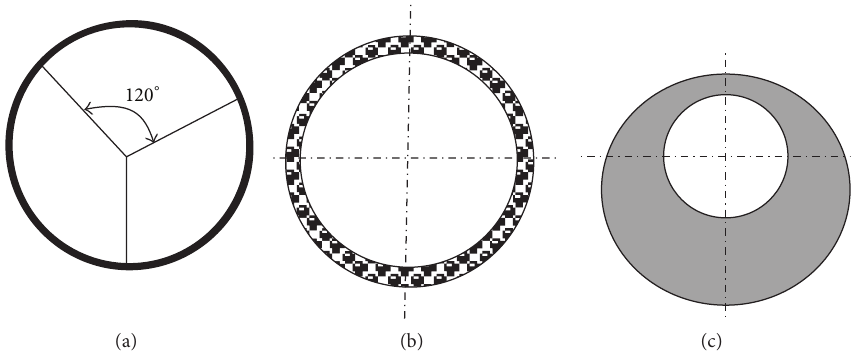
Figure 1: Cross section design of flexible pneumatic actuators (a) FMA, (b) FPA, and (c) AFPA.